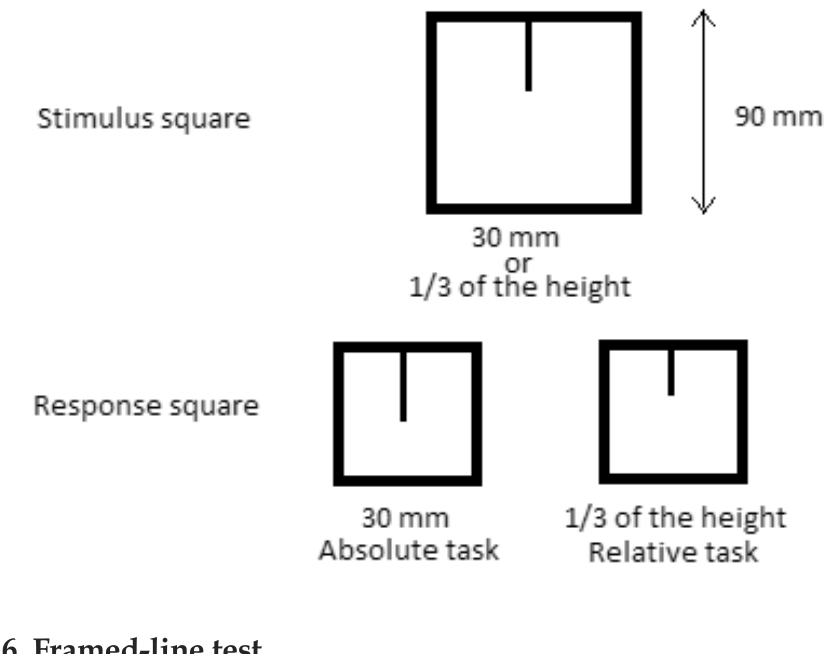
Fig. 6. Framed-line